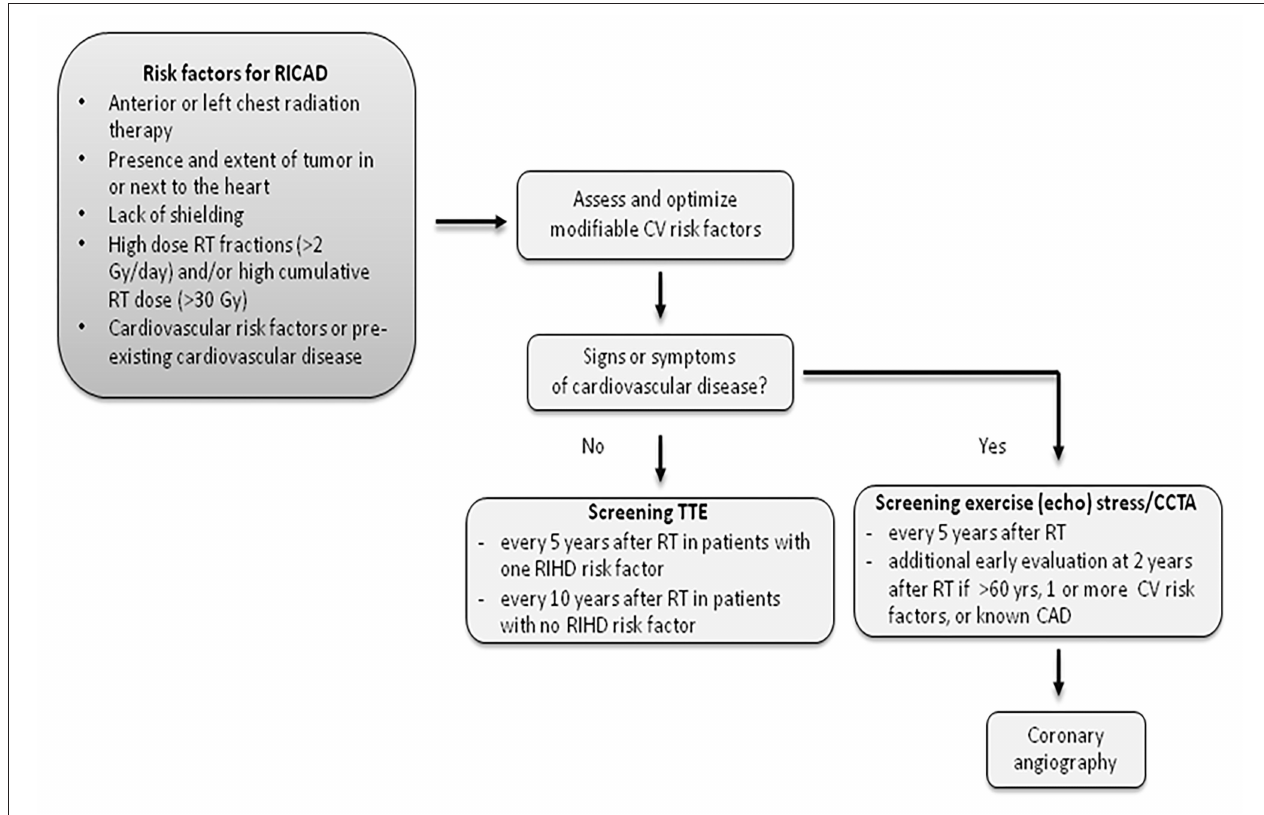
FIGURE 4 | Recommended screening for patients with RICAD. RICAD, radiation-induced coronary artery disease; RT, radiation therapy; CCTA, coronary computed tomography angiography; TTE, transthoracic